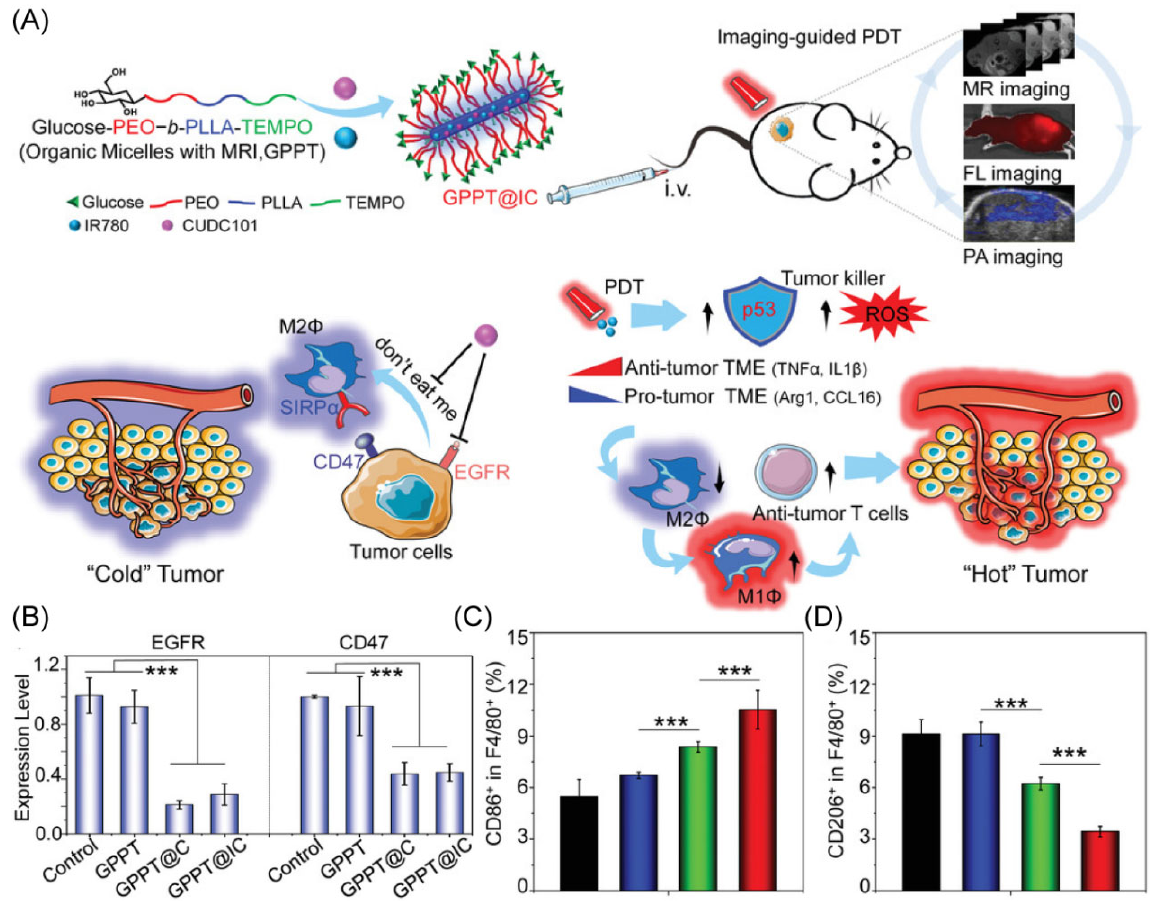
Figure 5. ( A ) Schematic diagram of the anti-tumor immune mechanism. ( B ) The RT-PCR was used to assess the suppression of EGFR and CD47 in Hep1-6. ( C , D ) M1-type TAMs and M2-type TAMs in the spleen of HCC mice under different treatments. *** p < 0.001. Copyright 2021, Wiley-VCH GmbH [72].